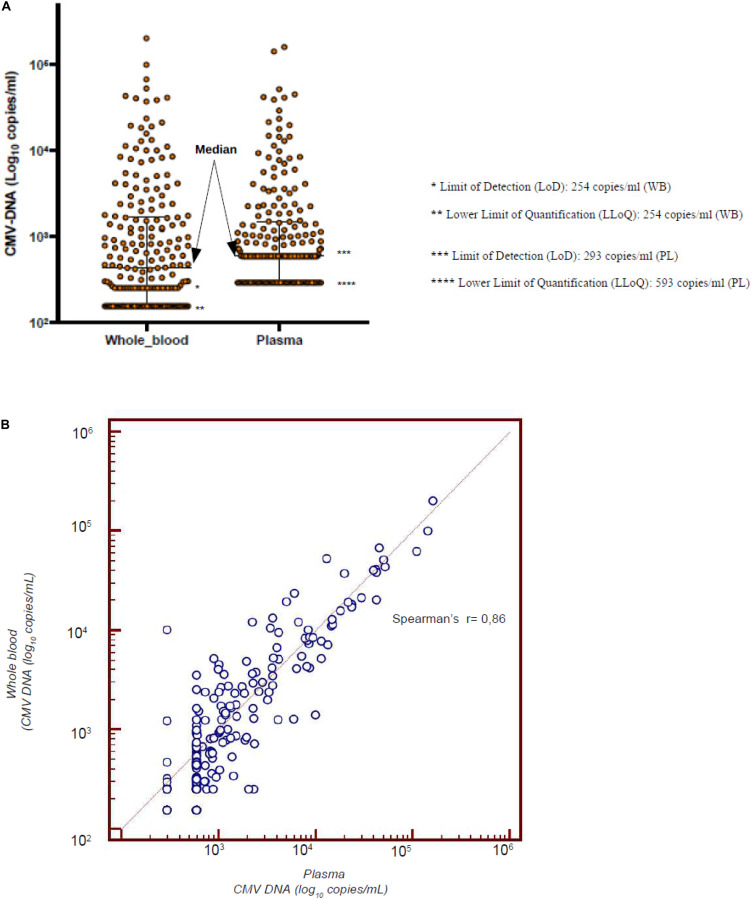
(A) Median value of CMV-DNAemia of the 18 patients with CMV reactivation who were monitored simultaneously from PL and WB. (B) Linear correlation between the CMV DNAemia assessed on PL and WB in the 18 patients who experienced a CMV reactivation.